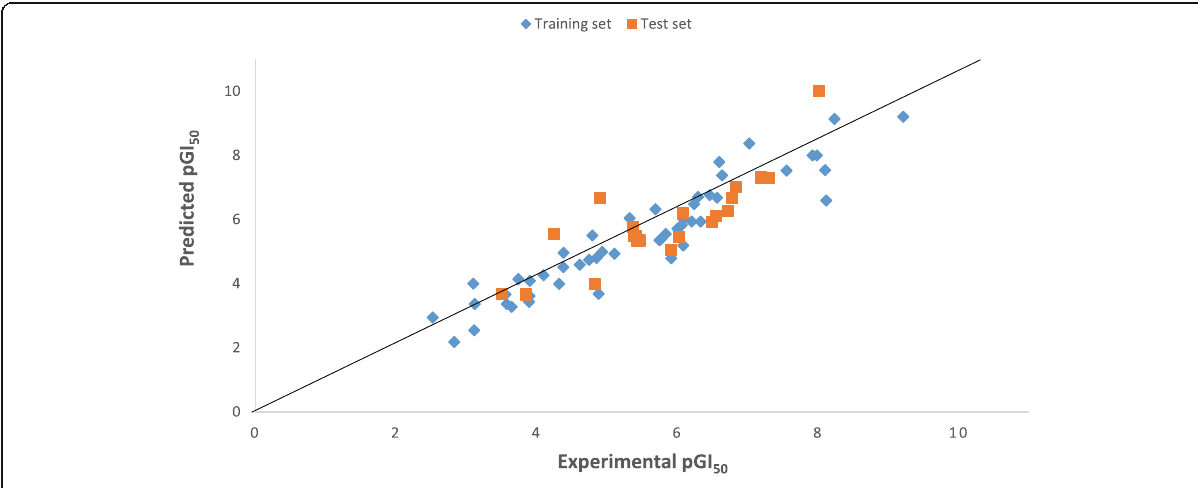
Fig. 1 The predicted pGI 50 against the experimental values for the training and test